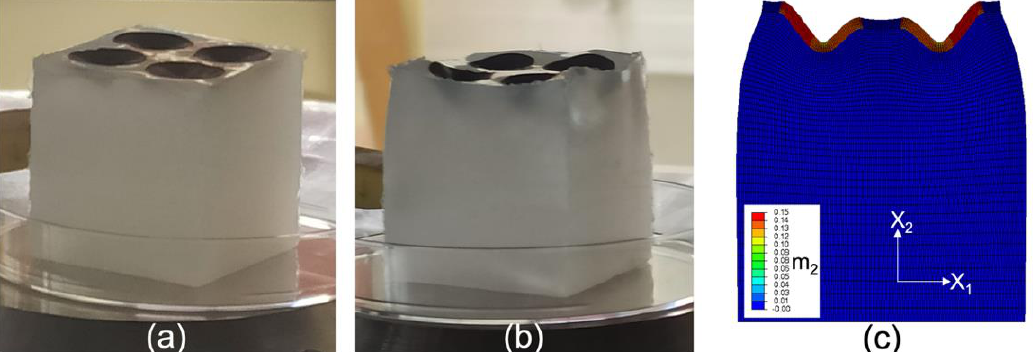
Figure 11. 3D-printed stiff heterogeneous magnetic layer resting on a soft non-magnetic substrate submitted to a uniform magnetic field perpendicular to the layer (and pointing upwards), and showing 3D surface patterns under an applied field of ( a ) 0.4 T and ( b ) 0.8 T. ( c ) A 2D finite element simulation showing the inwards movement of the stiff magnetic discs into the soft non-magnetic substrate, where m 2 (A/ µ m) is the magnetization in the X 2 -direction under an applied field of 0.4 T and is plotted on the deformed